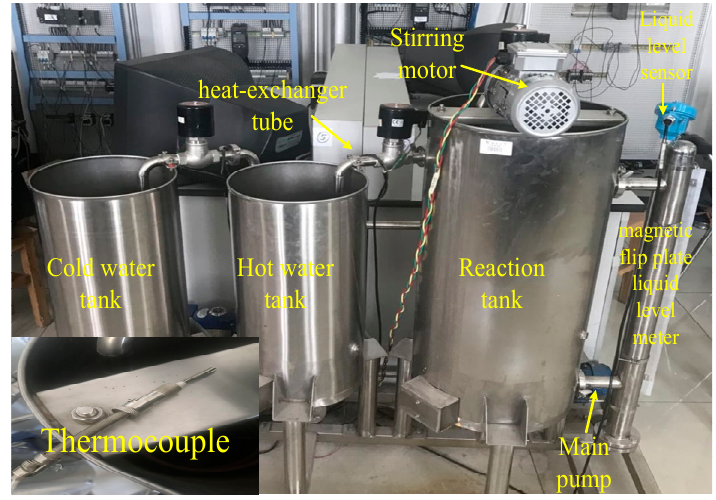
Figure 15. Experimental equipment diagram.